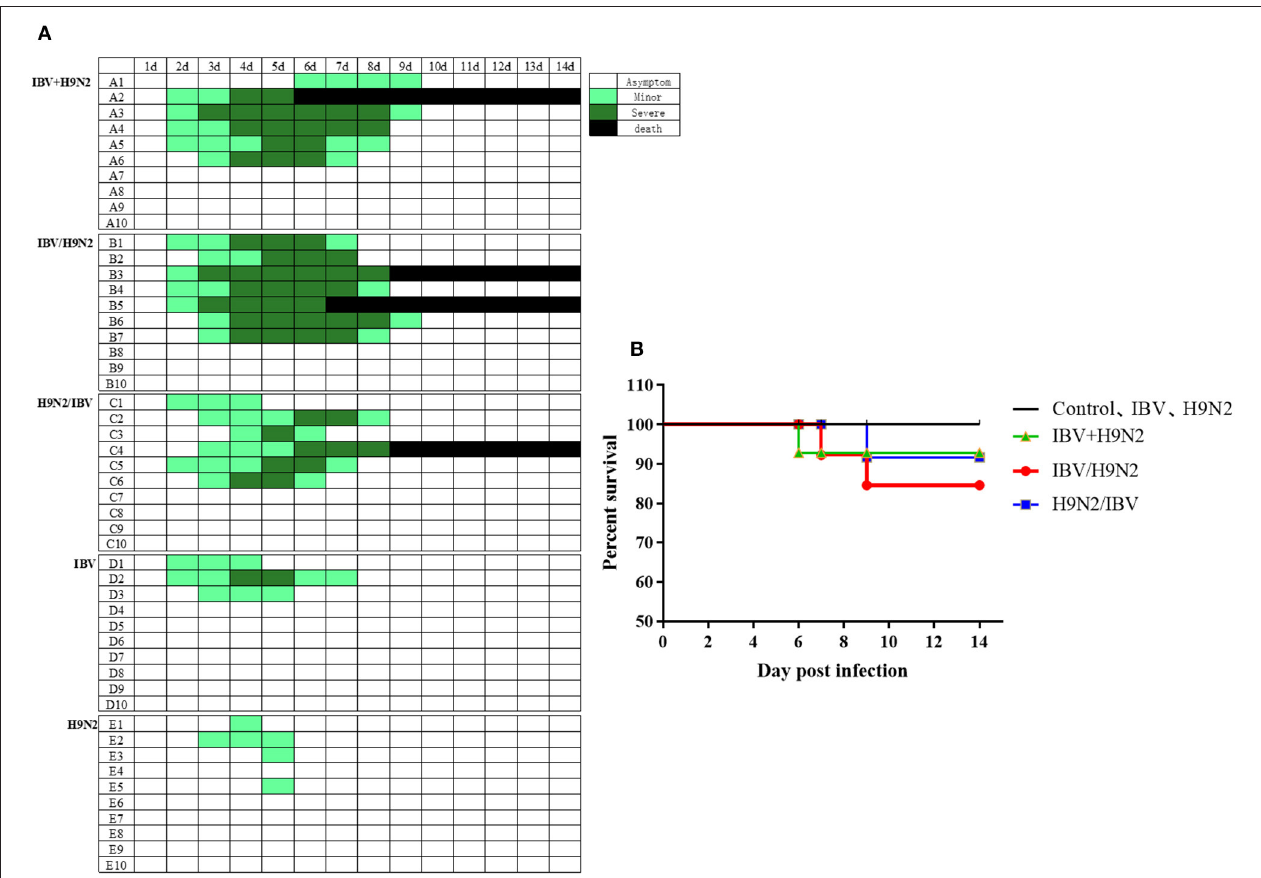
FIGURE 1 | Clinical signs and mortality of chickens after co-infection with IBV and H9N2 virus. (A) Clinical symptoms were observed once daily, and scored according to degree of severity. (B) Mortality rates of chickens after co-infection with IBV and H9N2 virus. IBV, infectious bronchitis virus.